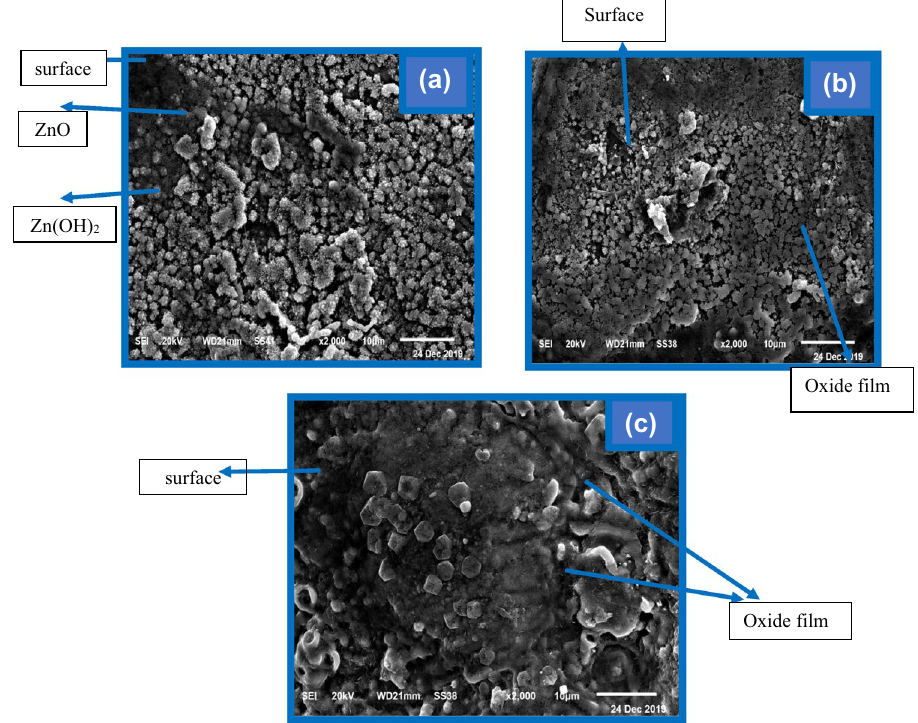
Figure 10. Captured SEM images for the anodically produced film at pristine zinc ( a ), and its alloys I ( b ), and II ( c ) at − 1.27 V in the 6 M KOH solution.